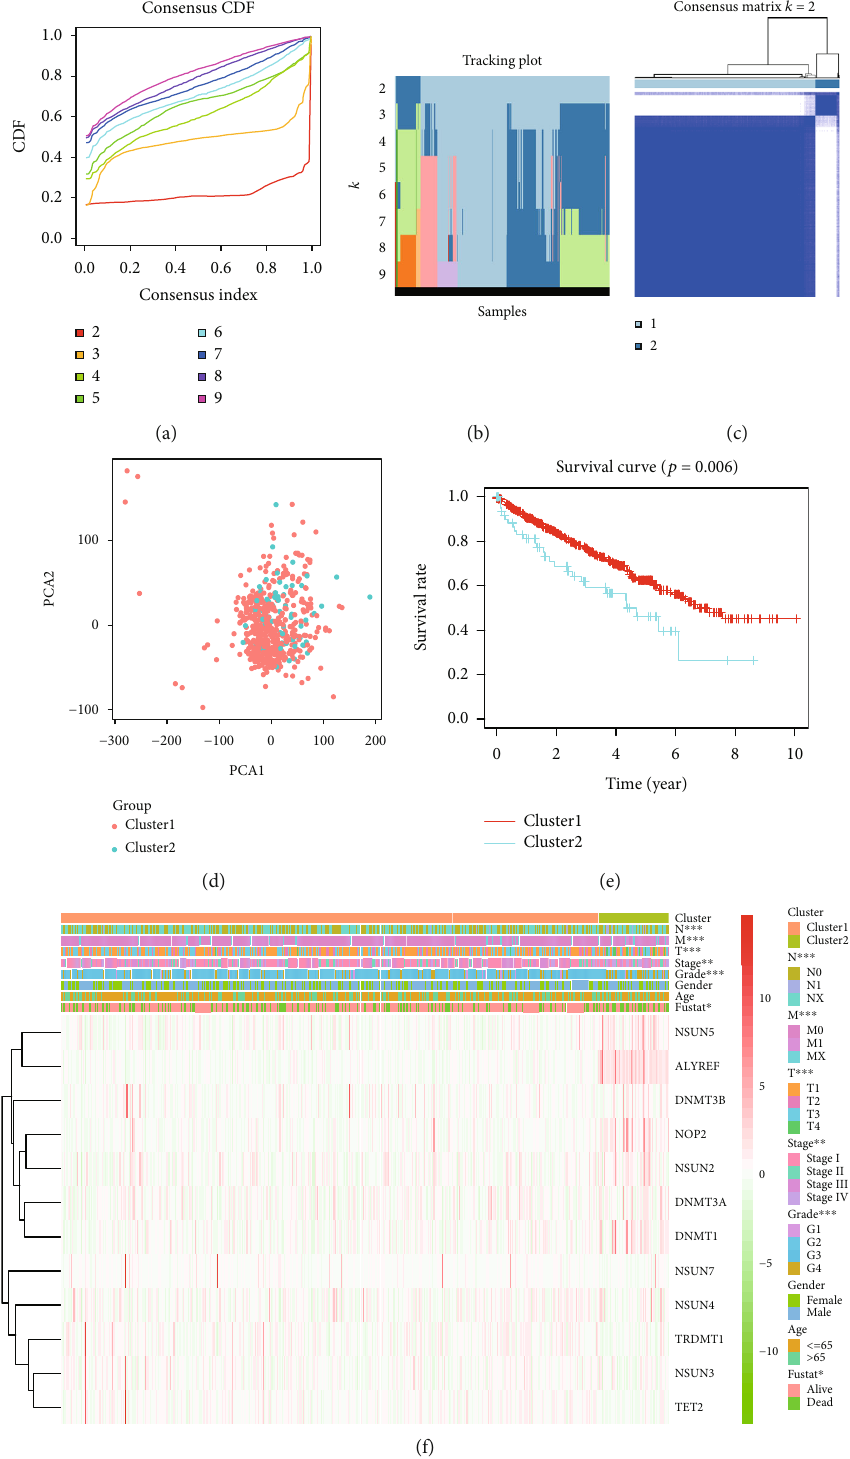
Figure 5: Consensus clustering analysis shows two clusters of ccRCC patients with di ff erential prognosis. (a) Cumulative distribution function (CDF) curves for the consensus score ( k = 2 to 9). (b) The tracking plot for k = 2 to 9. (c) Consensus clustering matrix for the optimal cluster number, k = 2 . (d) Principal component analysis of the total RNA expression pro fi le. ccRCC in cluster 1 and 2 are marked in red and blue, respectively. (e) Kaplan-Meier overall survival (OS) curve for ccRCC patients in cluster 1 and 2. (f) The expression heatmap of the 12 m 5 C methylation regulatory genes in cluster 1 and cluster 2 patients that were strati fi ed according to the clinicopathological parameters: namely, N stage (N0, N1, or NX), M stage (M0, M1, or MX), T stage (T1-T4), AJCC stages (stages I, II, III ,or IV), grade (G1-G4), gender (male or female), age ( > 65y or < 65y), and survival status (alive or dead). ∗ p < 0 : 05 , ∗∗ p < 0 : 01 , and ∗∗∗ p < 0 : 001